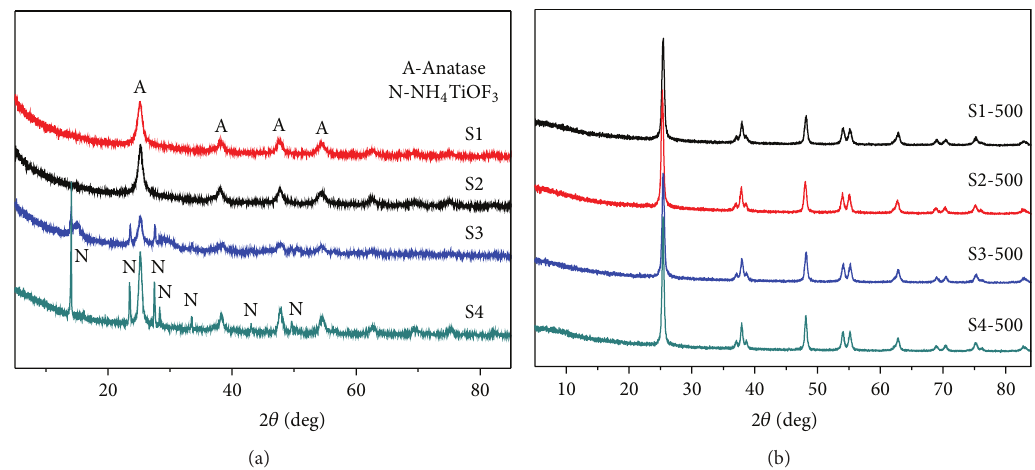
Figure 1: XRD patterns of all samples ((a) the uncalcined samples, (b) the calcined